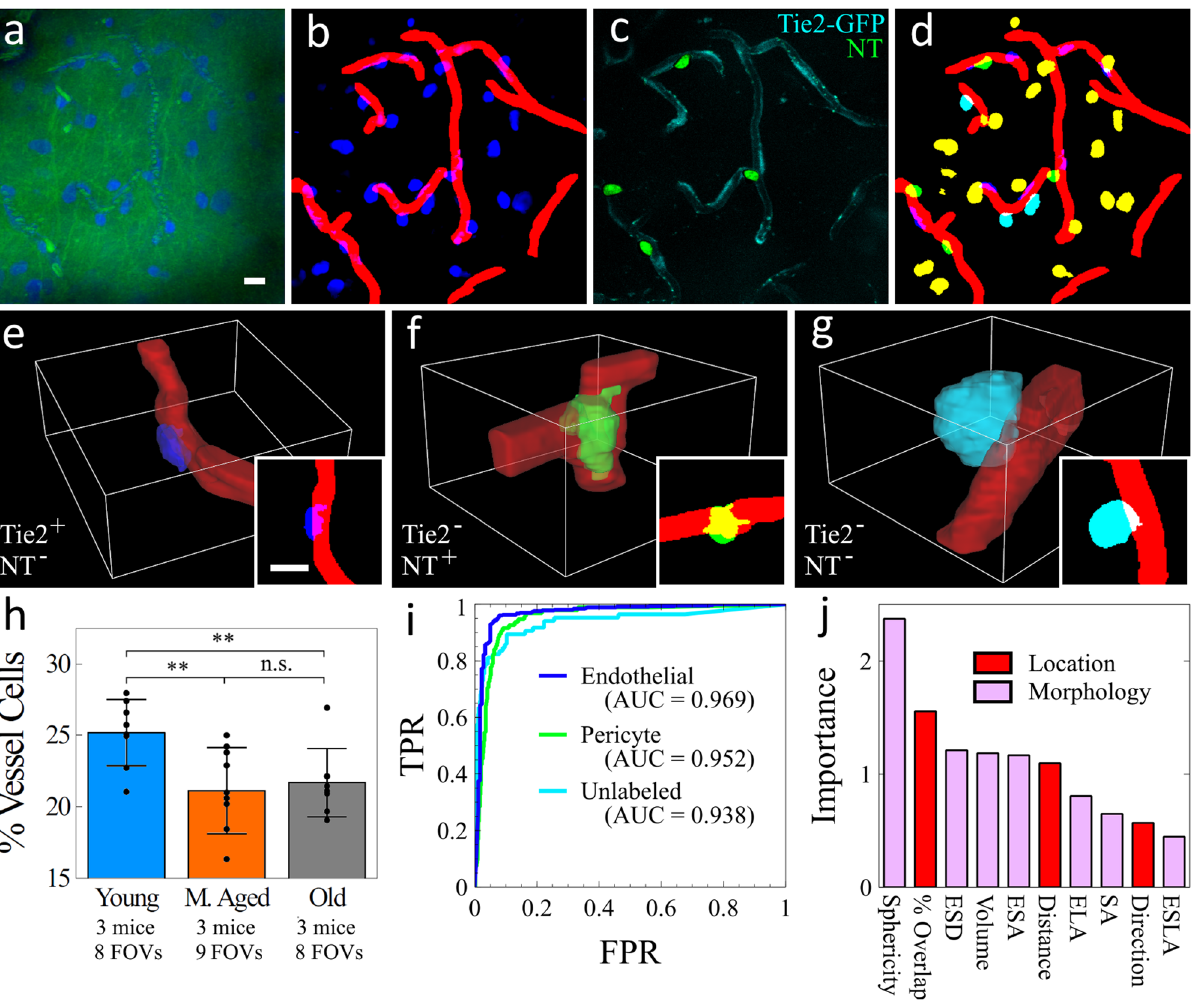
Fig. 3 In vivo label-free cell identi fi cation of capillary-lining cells. a SRS imaging intensity projection of 25 µ m of Tie2-GFP mouse. Green shows SRS of lipids and TAM of hemoglobin. Blue shows the spectrally unmixed proteins. b Spectrally unmixed proteins (blue) and capillaries (red). c Two TPEF fl uorophores: GFP (green) and Neurotrace 500/525 (cyan). d Composite image of non-capillary-lining cells (yellow), unlabeled capillary-lining cells (cyan), pericytes (green), and endothelial cells (blue). e – g 3D rendering of an endothelial cell, a pericyte, and an unlabeled cell, respectively, with corresponding 2D projection. h Percentage of vessel cells out of total cell population with age. Error bars represent standard deviation. i ROC curves of prediction accuracy for predicting endothelial cells, pericytes, and unlabeled cells based on morphological and locational features. j Importance of each feature in the machine- learning classi fi er. Red features indicate the location of the cell to the capillary, pink features indicate morphology. Scale bars: 10 µ m. ** p <